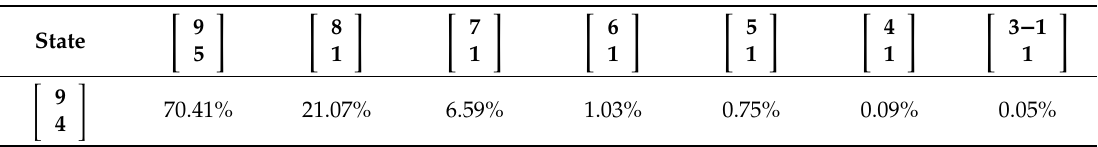
Table 2. Transition probabilities for a bridge in state (cid:3427) (cid:2877)